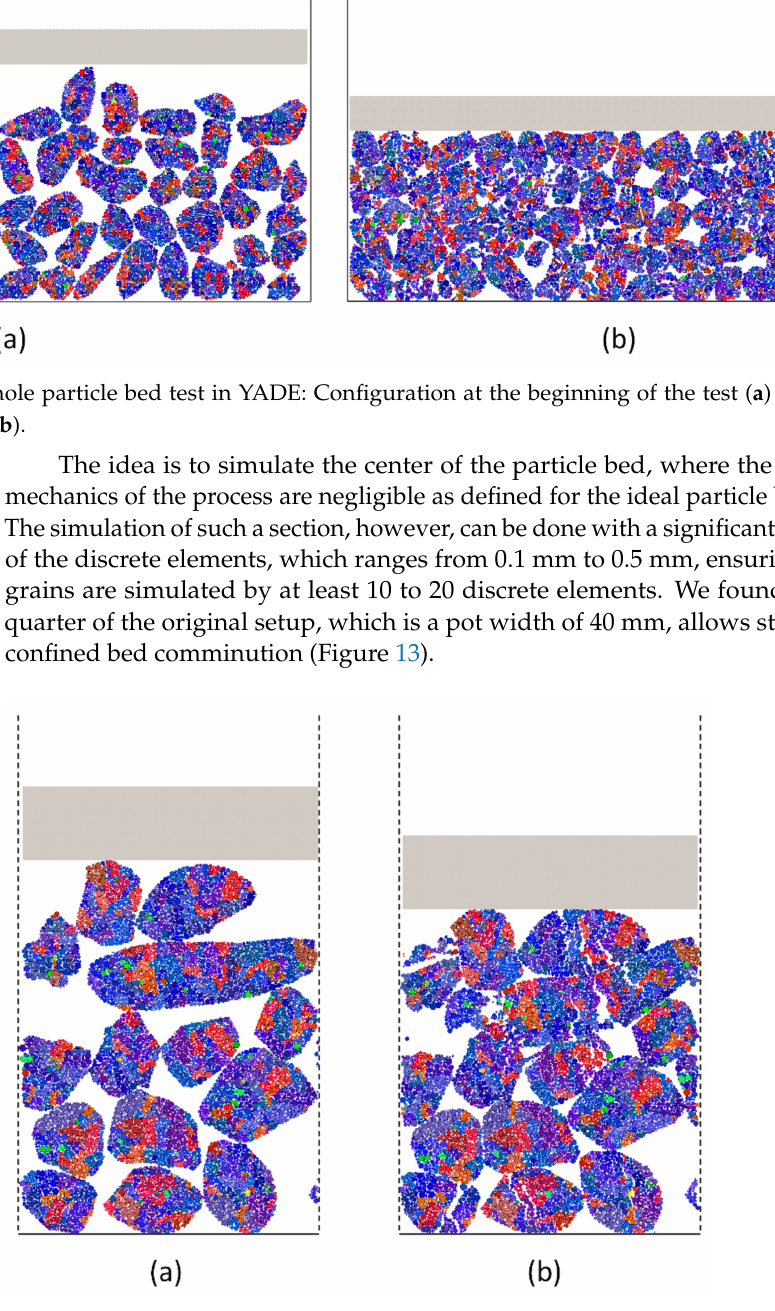
Figure 13. Setup of the detailed section of the particle bed test with periodic boundaries in YADE. The periodic boundaries are indicated by the dashed vertical lines: Configuration at the beginning of test ( a ) and during the particle bed comminution ( b